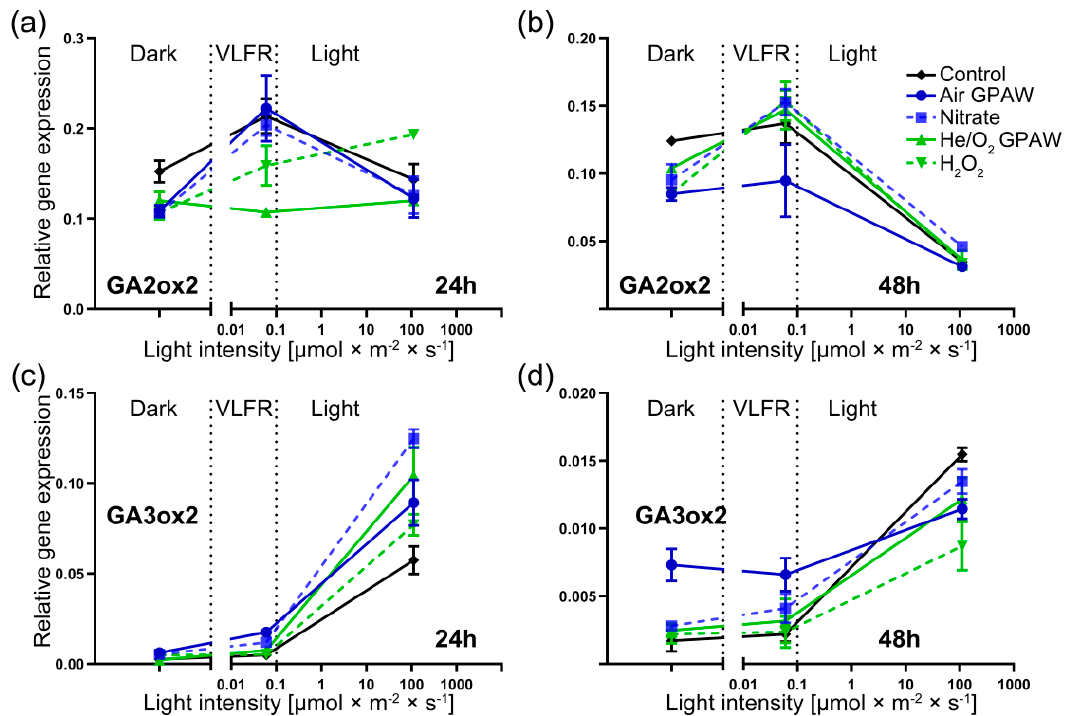
Figure 5. Relative gene expression of freshly harvested Nicotiana tabacum seeds displaying photo- dependent dormancy and germination responses in three different continuous light conditions (darkness (0 µmol m − 2 s − 1 ), VLFR-intensity white light (0.05 µmol m − 2 s − 1 ) and LFR-intensity white light (111 µmol m − 2 s − 1 )) at 2 time points (24 and 48 h). Seeds were incubated at 20 °C with 5 treatments: Air GPAW, He/O 2 GPAW, Nitrate (5 mM KNO 3 − ), H 2 O 2 (300 µM), and water. ( a , b ) Gene expression of GA2ox2 at 24 and 48 h, respectively. ( c , d ) Gene expression of GA3ox2 at 24 and 48 h, respectively.